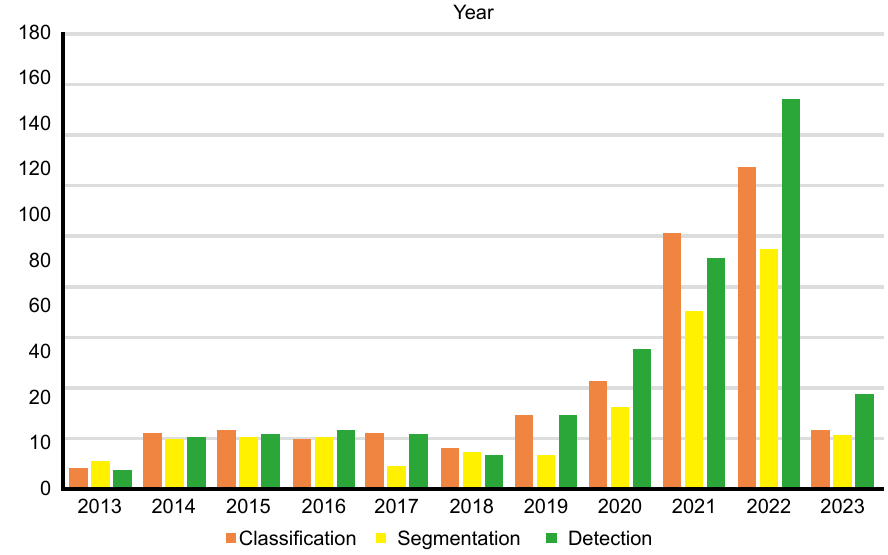
Figure 1 The results of AI-based ultrasound image processing research in classification, segmentation and detection in the past ten